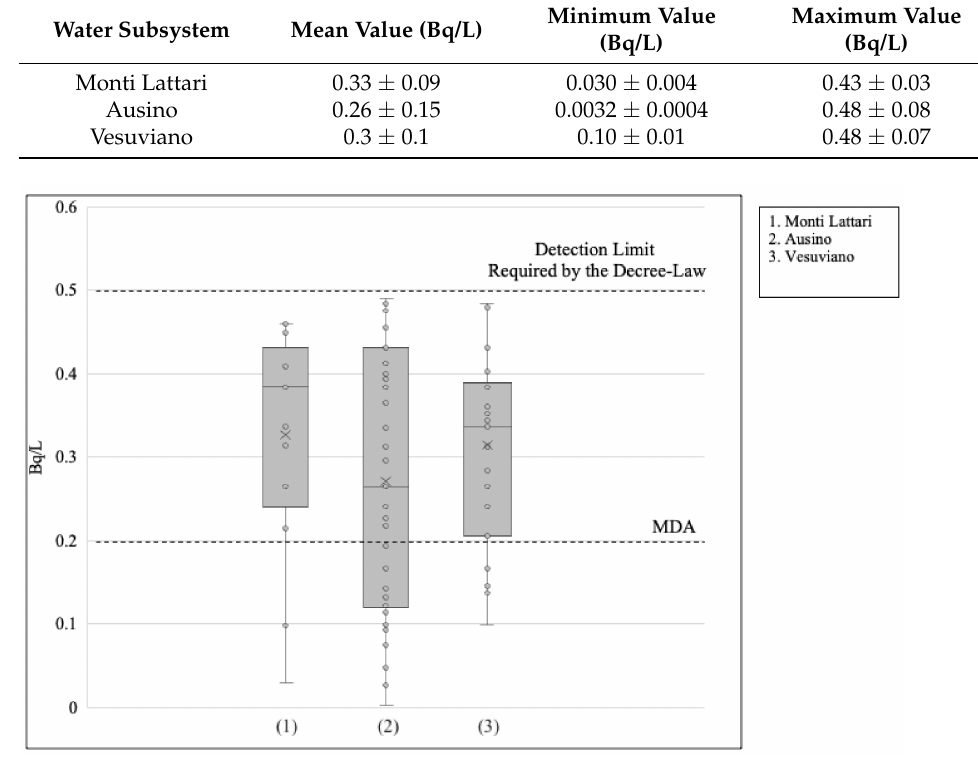
Figure 3. Variability of alpha activity concentration of the water subsystems. The graph reports median, 25th, and 75th percentile. Additionally, two horizontal lines represent the value of the MDA equal to 0.2 Bq/L and to the detection limit required by the Decree-Law equal to 0.5